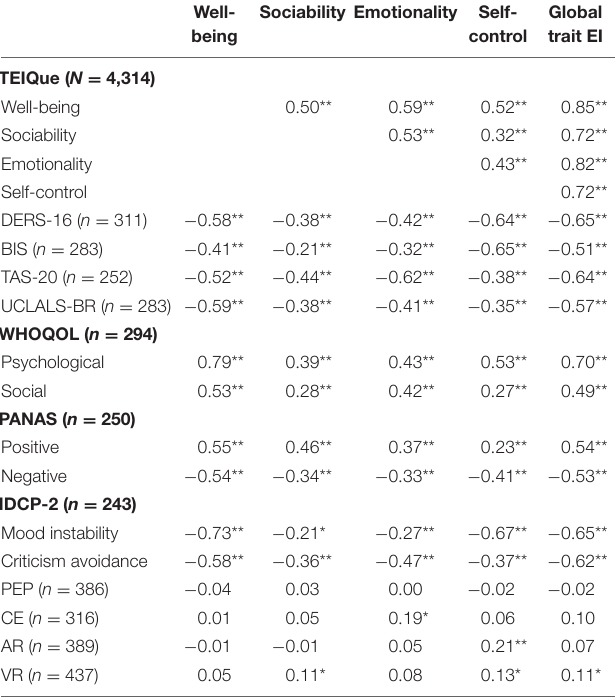
TABLE 4 | Correlations between key variables in the